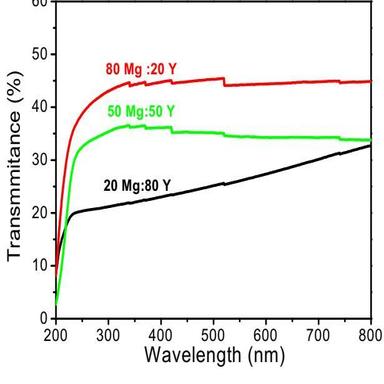
Optical transmittance of the produced MgO-Y2O3 nanocomposite at different Mg2+ ion content (a) 20 Mg:80Y, (b) 50 Mg:50Y and (c) 80 Mg:20Y annealed at 600 C for 2 h.